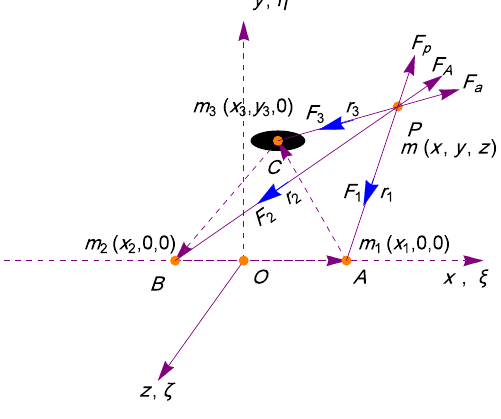
Fig. 1 Configuration of the problem in CRFVBP with the effect of oblateness and